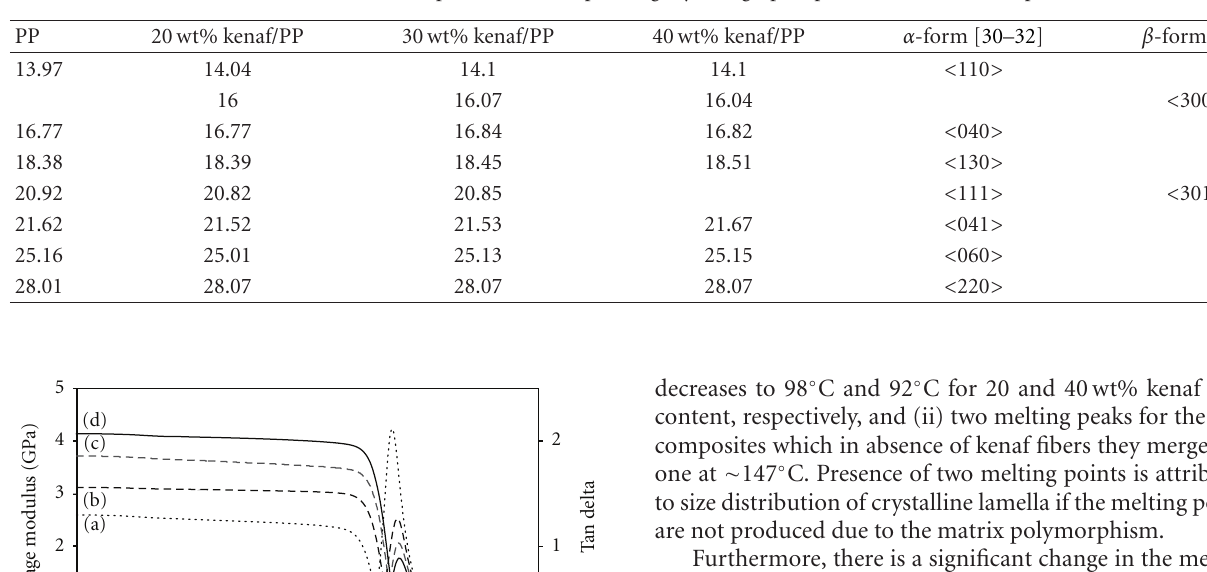
Table 3: Characteristic XRD peaks and corresponding crystallographic planes of kenaf/PP composites.